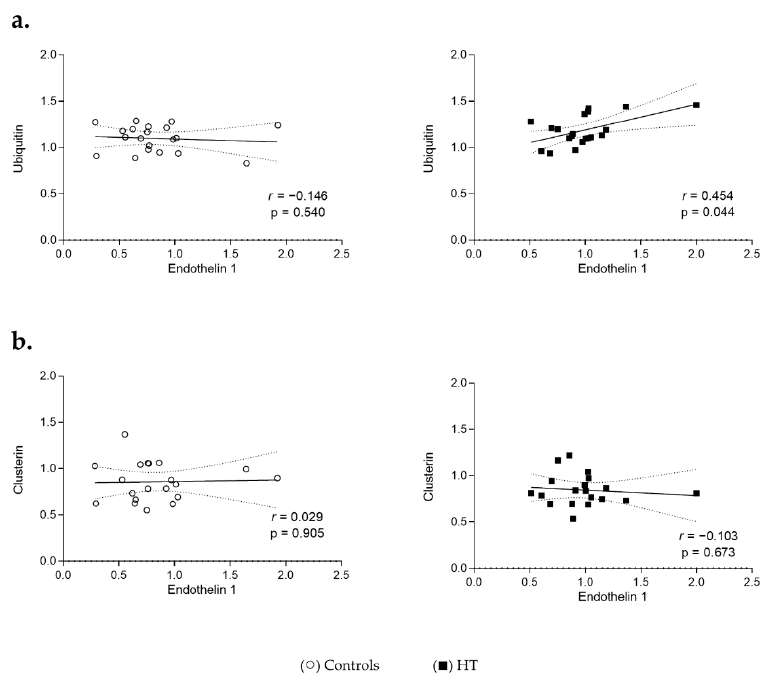
Figure 3. Association between hypertension and proteostasis-related proteins. The levels of Endothe- lin 1 in the plasma of controls ( ○ ) and individuals with hypertension ( ■ ) were matched with the corresponding individual levels of Ubiquitin ( a ) or Clusterin ( b ). Spearman’s rank coefficient was applied to test the strength and direction of the relationships between Endothelin 1 and Ubiquitin or Clusterin. The resulting coefficients (r) and corresponding p -values (p) are represented. p < 0.05 was considered statistically significant. All samples were normalized to the reference sample and protein levels are represented as fold changes relative to this reference sample. Lines represent a linear regression fit with corresponding 95% confidence bands (dotted lines).